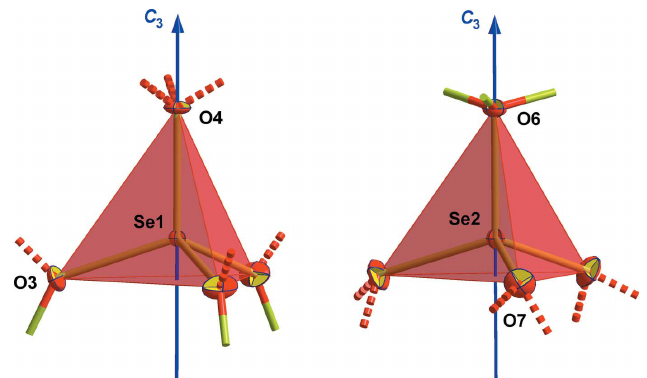
Figure 2 Ball-and-stick models of the two crystallographically independent [SeO 4 ] 2 (cid:3) ions with atom numbering of the asymmetric unit and orientation of the threefold rotation axis (blue). With exception of the hydrogen atoms, which are shown as spheres of arbitrary radius, all other atoms are drawn as displacement ellipsoids at the 40% level. Coordina- tion bonds between oxygen and barium are drawn as shortened, two- colored sticks, hydrogen bonds between oxygen and hydrogen atoms of water molecules and hydroxyl groups are drawn as dashed lines